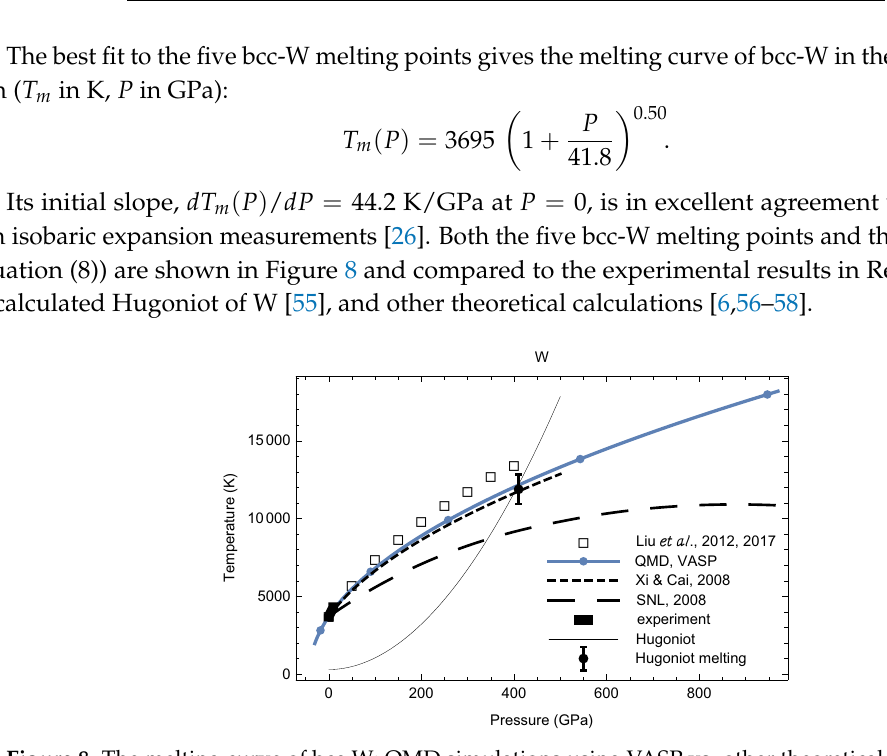
Figure 8. The melting curve of bcc-W: QMD simulations using VASP vs. other theoretical calculations (Xi an Cai [56]; SNL, 2008 [57]; and Liu et al., 2012 [6] and 2017 [58]), the low-pressure melting data (experiment in Reference [30]), and the experimental shock melting datapoint (Hugoniot melting [27]). The calculated Hugoniot is shown as a thin black